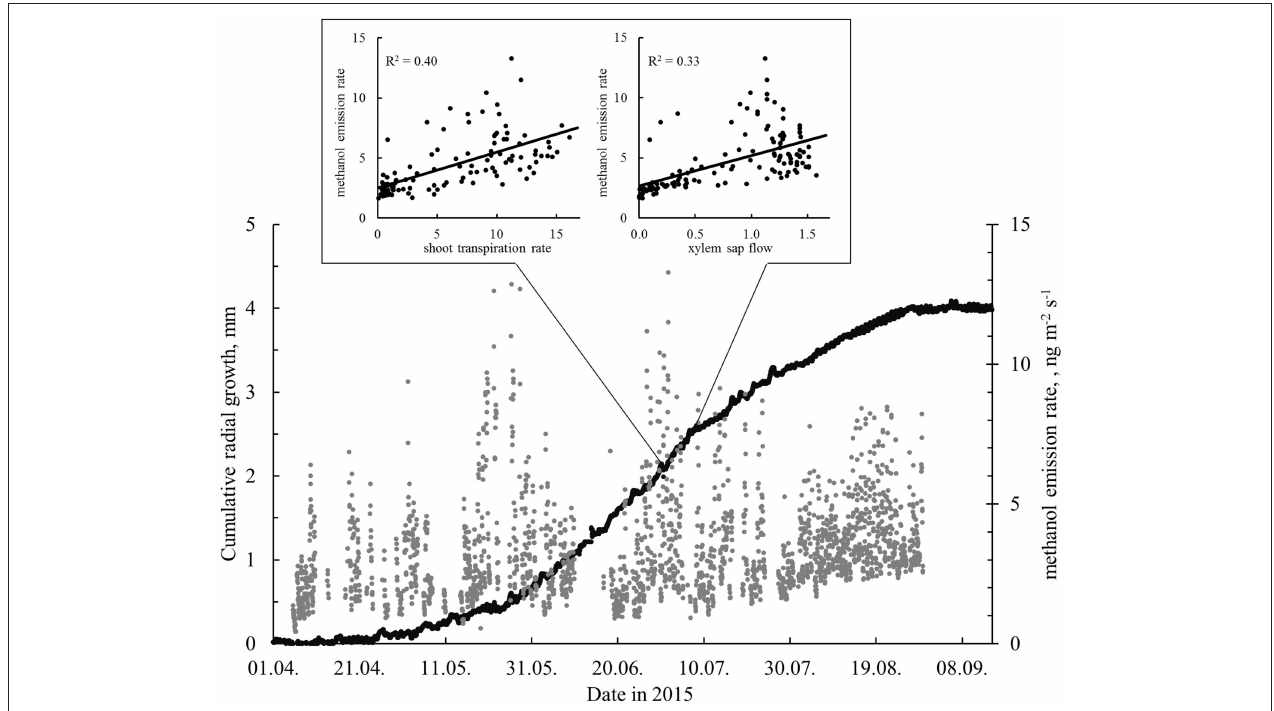
FIGURE 7 | The cumulative modeled radial growth and methanol emission rates (ng m − 2 s − 1 , stem enclosure 4, relative humidity of the air < 70%) in April–September 2015. The inset shows the relationships between the shoot transpiration rate (mg m − 2 s − 1 ), xylem sap flow (l h − 1 ), and the methanol emission rate (ng m − 2 s − 1 ) for the period 1–7 July with highest number of enlarging cells. All data were measured from the same tree (#2). The methanol data gap in mid-June is due to a malfunction of the measurement